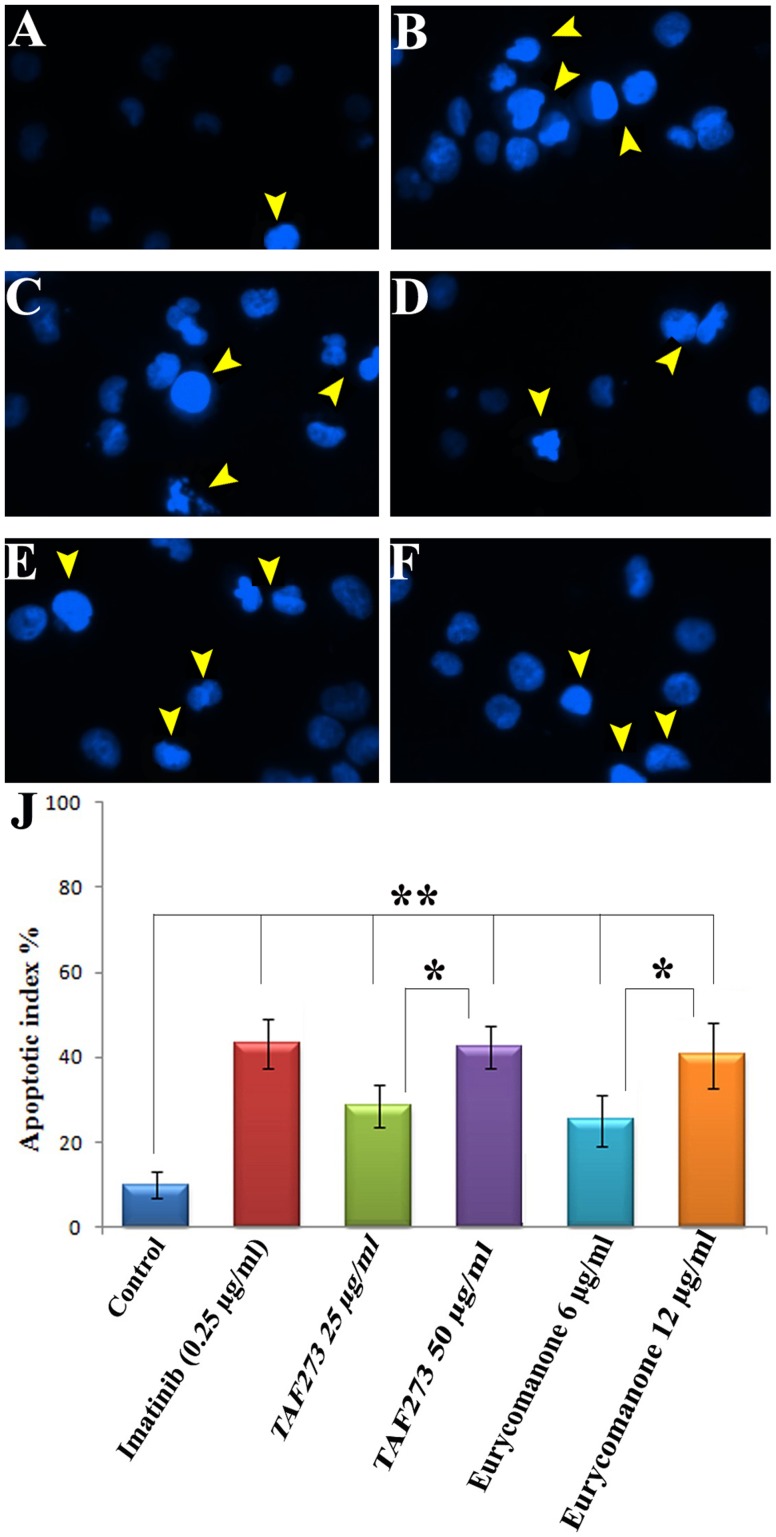
Nuclear morphology and apoptotic index of K-562 cells.K-562 cells were treated with TAF273 and eurycomanone and stained with Hoechst 33342 (10 µg/ml) for 96 h. K-562 cells treated with imatinib and untreated cells were acted as positive and negative control respectively. Cells with nuclear condensation are labeled with arrowheads Original magnification of 20×. Apoptotic index was calculated as: (the number of nuclei with chromatin condensation/the total number of nuclei)×100%. A: untreated cells; B: imatinib (0.25 µg/ml); C: TAF273 (50 µg/ml); D: TAF273 (25 µg/ml); E: eurycomanone (12 µg/ml); F: eurycomanone (6 µg/ml); J: apoptotic index. (*) indicates P<0.05 and (**) indicates P<0.01.